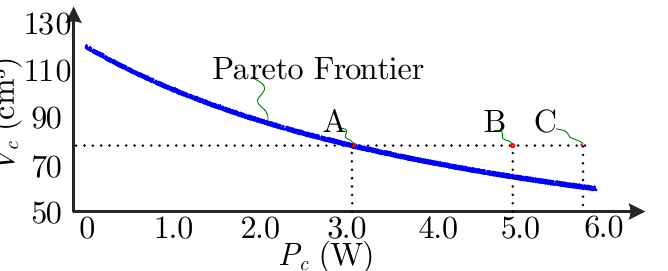
Figure 12. Pareto frontier of the proposed integrated magnetic structure: A: selected optimal design of the proposed integrated magnetic structure; B: conventional design; C: unoptimized design of the proposed integrated magnetic structure.